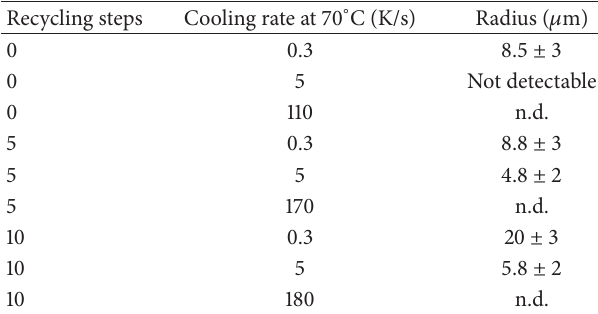
Table 2: Cooling rates imposed during solidification and average radius of the